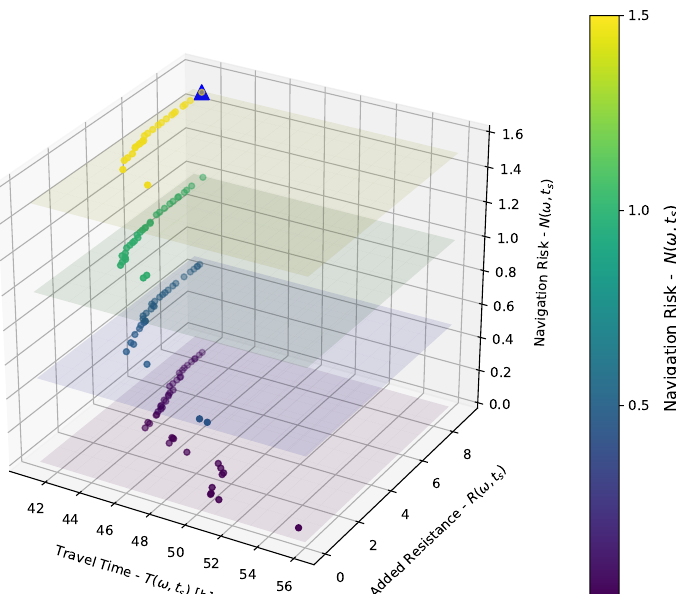
Figure 8. Set of Pareto efficient solutions at the output of the planning layer for the selected scenario. Each axis represents a different criterion: x axis—travel time, y axis—navigation added resistance and z axis—navigation risk. The solutions are also grouped by navigation risk color, with dark (purple, blue) and light (green, yellow) colors for low and medium-high risks, respectively. The blue triangular marker identifies the costs associated with the nominal route